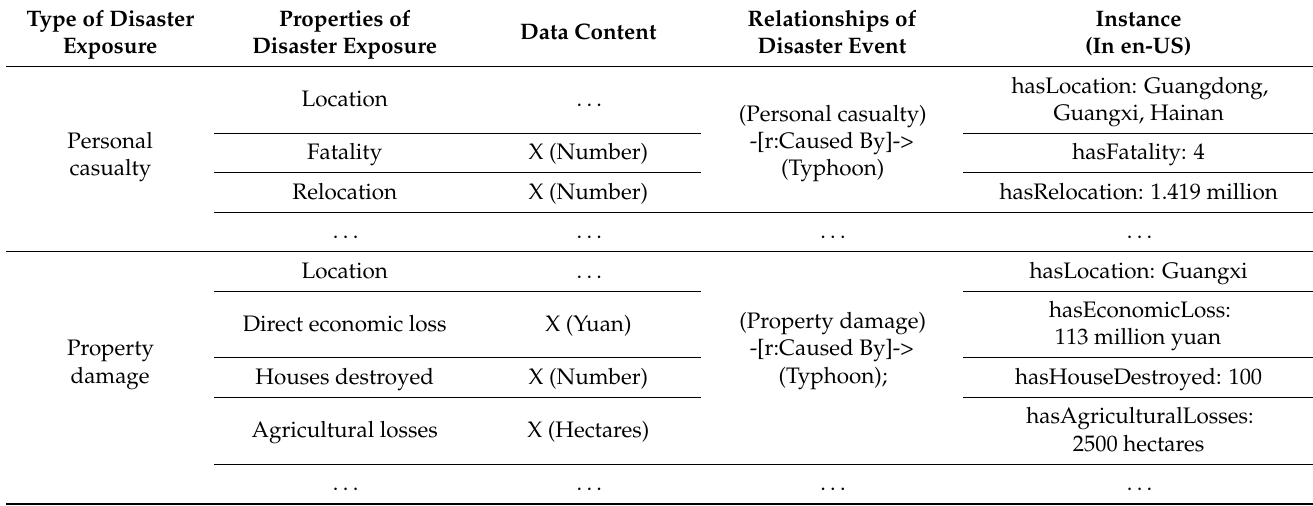
Table 4. Part of Disaster Exposure description.